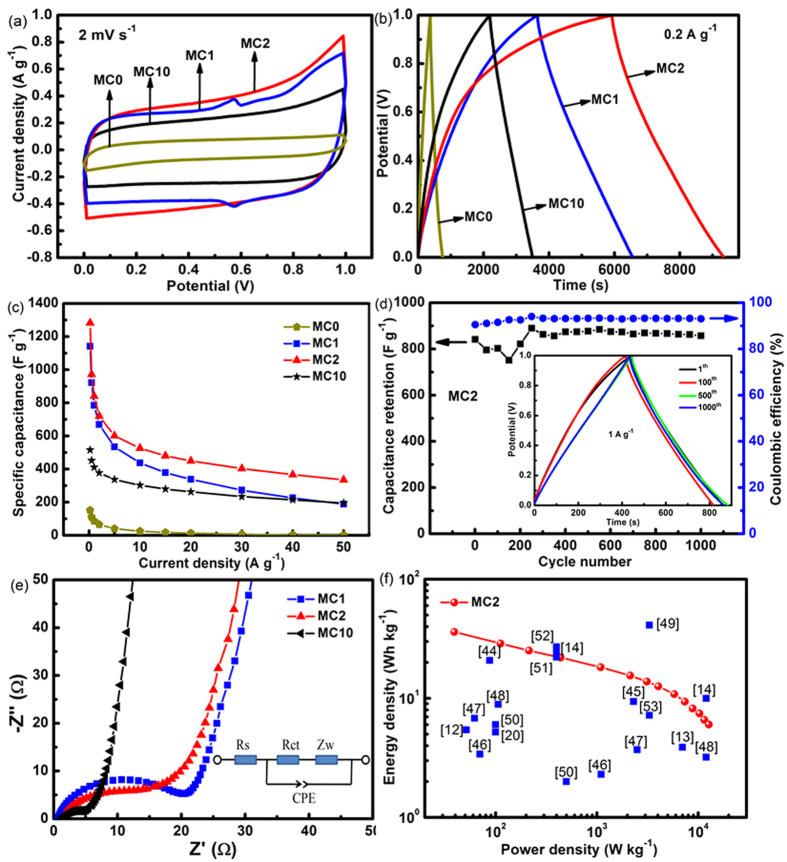
Electrochemical performances of MC composites (a) Cyclic Voltammetry (CV) curves of the MC composites at the scan rate of 2 mV s-1, (b) charge/discharge curves of the MC composites at the current density of 0.2 A g-1, dependences of (d) specific capacitance on current density for the MC composites and (e) specific capacitance and coulombic efficiency on cycle number for MC2 with the inset showing the charge/discharge curves in different cycles, (f) Nyquist plots of the EIS for MC1, MC2 and MC10 composites with the inset showing the equivalent circuit used, (g) Ragone plots for the present MC2 composites in comparison with published data.